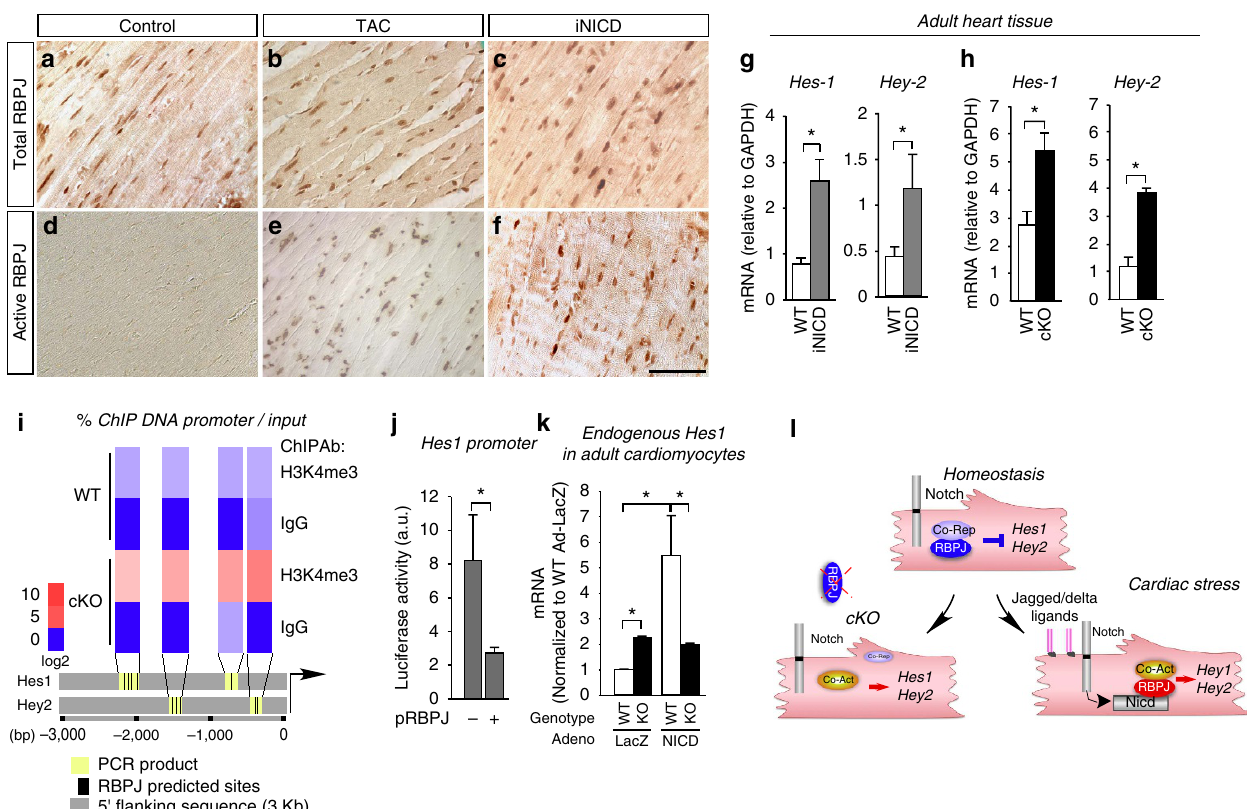
Figure 1 | Cardiac stress switches RBPJ from transcriptional repression to activation. ( a – f ) Histological sections of ventricular myocardium from WT mice from sham ( a , d ) and TAC ( b , e ) operated mice, and a cardiomyocyte-specific doxycycline-iNICD mouse ( c , f ) immunostained for total RBPJ ( a – c ) and RBPJ in its transcriptional activating complex(brown) ( d – f ). TAC and iNICD upregulate nuclear-localized RBPJ. Scale bar, 50 m m. ( g , h ) qRT-PCR of Notch target genes ( Hes1 , Hey2 ) in ventricular tissue from iNICD ( g ) and RBPJ cKO ( h ) with their respective WTcontrols showing upregulation of target genes in both cases. Error bars indicate SEM n ¼ 4 mice for each condition. mRNA levels were normalized to Gapdh levels. Asterisk, P o 0.05. ( i ) Heatmap representation of ChIP analysis of H3K4me 3 in the endogenous Hes1 and Hey2 loci of WT and cKO ventricular myocardium. PCR primers span RBPJ consensus binding motifs (see inset below heatmap). Specific H3K4me 3 and IgG PCR product levels were normalized to input DNA (see Methods section), revealing upregulated levels (red tones) of H3K4me 3 modified chromatin in the cKO relative to WT. ( j ) Activity of transfected RBPJ on a Hes1 promoter- luciferase construct in HEK 293T cells. Error bars indicate SEM n ¼ 5 per condition. Asterisk, P o 0.05. ( k ) Activity of endogenous Hes1 expression (qRT-PCR) in isolated ACM, 48h after adenoviral infection to overexpress NICD compared to inert gene (LacZ) control. Error bars indicate SEM n ¼ 4 mice for each condition. mRNA levels were normalized to b -actin levels and plotted relative to WT Ad-LacZ condition. Asterisk, P o 0.05. ( l ) Model showing that RBPJ toggles between transcriptional repression (basally) and activation in response to Notch activation. Loss of RBPJ (cKO) de-represses target